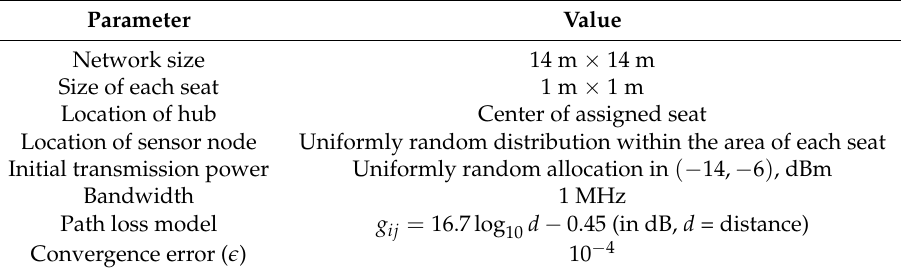
Table 3. Commonly-used simulation